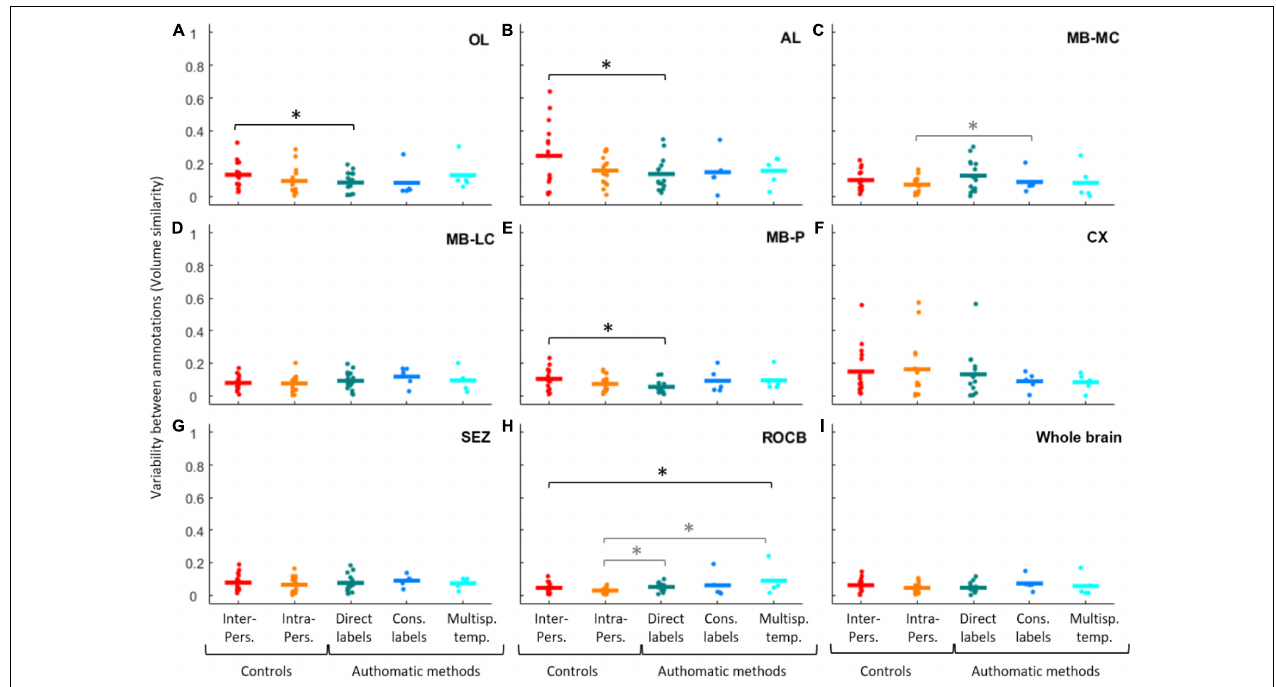
FIGURE 3 | Variability between annotations for brain compartments and the whole brain. Variation (using volume similarity) given is for the (A) optic lobe (OL). (B) Antennal lobe (AL). (C) Mushroom body medial calyx (MB-MC). (D) Mushroom body lateral calyx (MB-LC). (E) Mushroom peduncle (MB-P). (F) Central complex (CX). (G) Subesophageal zone (SEZ). (H) For the rest of the central brain (ROCB). (I) For the whole brain. Statistical comparisons are made using bootstrapping tests for comparing the volume differences found between the manual and the automatic labels (“Direct labels,” “Cons. Labels,” and “Multisp. temp.”) and